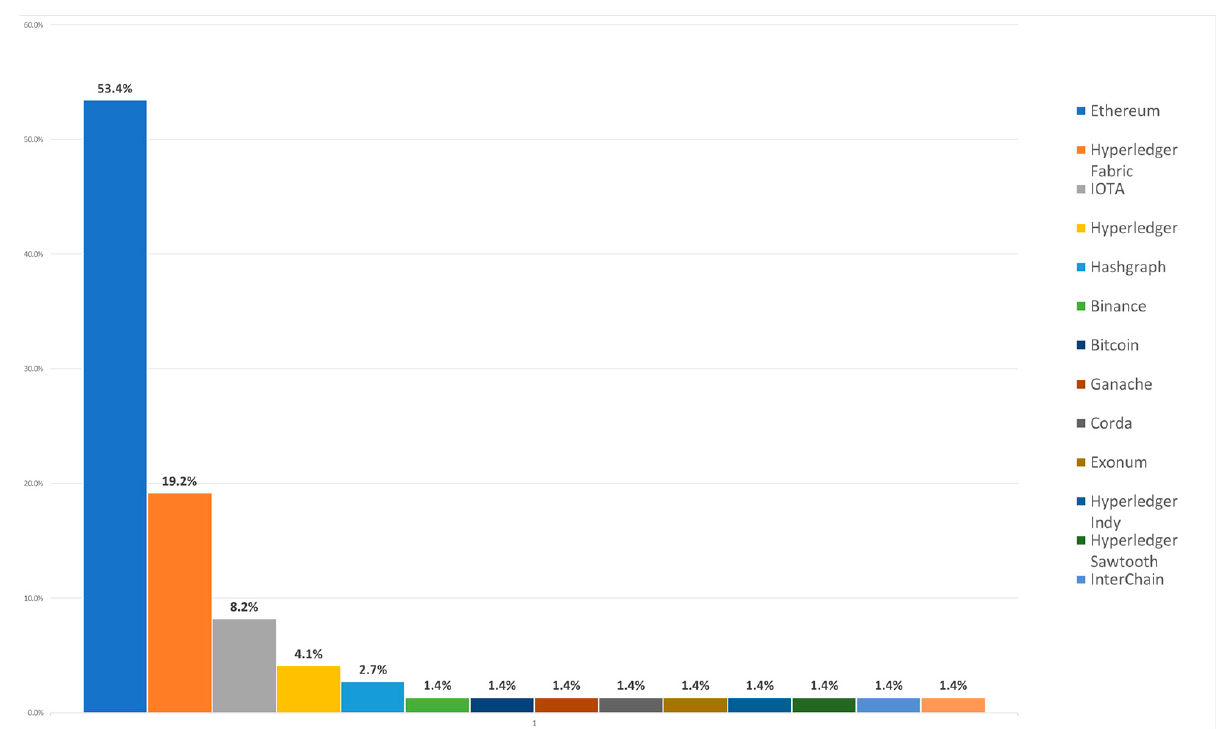
Figure 9. Blockchain application in the IoV—classification according to blockchain platform.